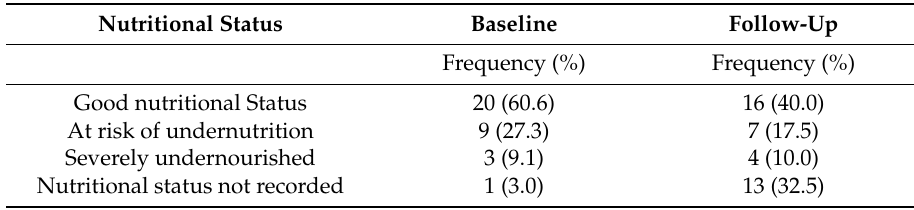
Table 3. Documented nutritional status in the medical records at baseline (n = 33) and follow-up (n = 40).